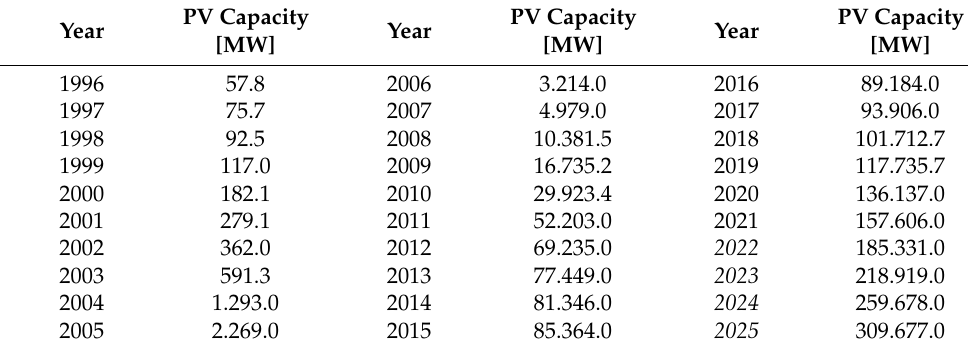
Table 2. Cumulative capacity of installed PV in the EU between 1996–2025.